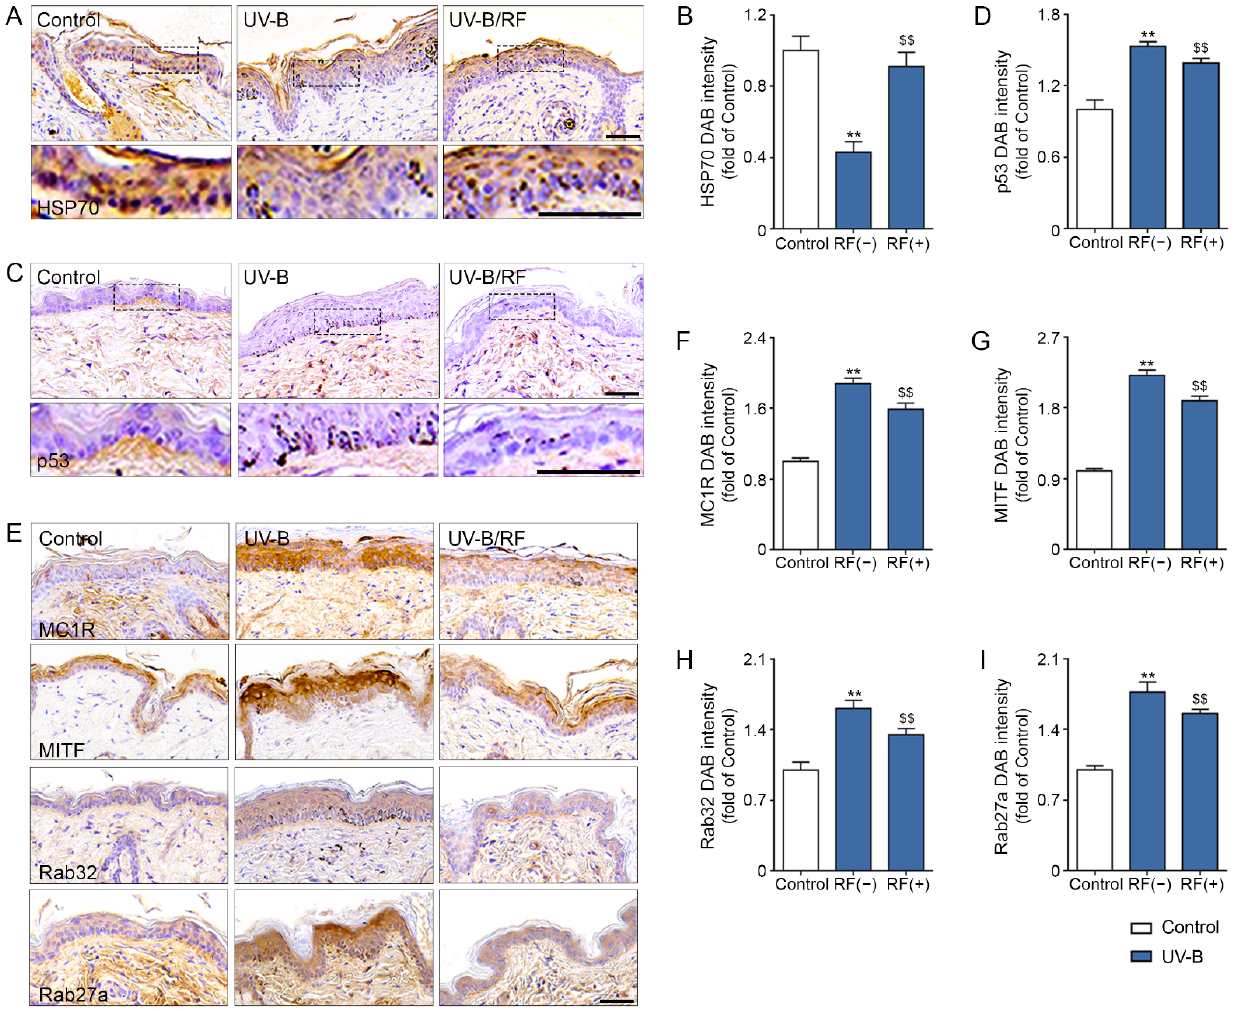
Figure 3. Upregulation of HSP70 and downregulation of p53, MC1R, and MITF by RF in UV-B exposed skin ( A – D ). HSP70 and p53 expression levels of UV-B exposed mouse skin were evaluated immunohistochemically (scale bar = 100 μ m). ( E – I ) MC1R (fist lane of E , F ), MITF (second lane of E , G ), Rab32 (third lane of E , H ), and Rab27a (fourth lane of E , I ) expression levels of UV-B exposed mouse skins were evaluated immunohistochemically (scale bar = 50 μ m). HSP70, 70 kilodalton heat shock proteins; MC1R, melanocortin 1 receptor; MITF, microphthalmia-associated transcription factor; Rab32, ras-related protein Rab-32; Rab27a, ras-related protein Rab-27a; RF, radiofrequency; UV-B, ultraviolet-B; **: p < 0.01 vs. control; $$: p < 0.01 vs. UV-B/RF ( − ).